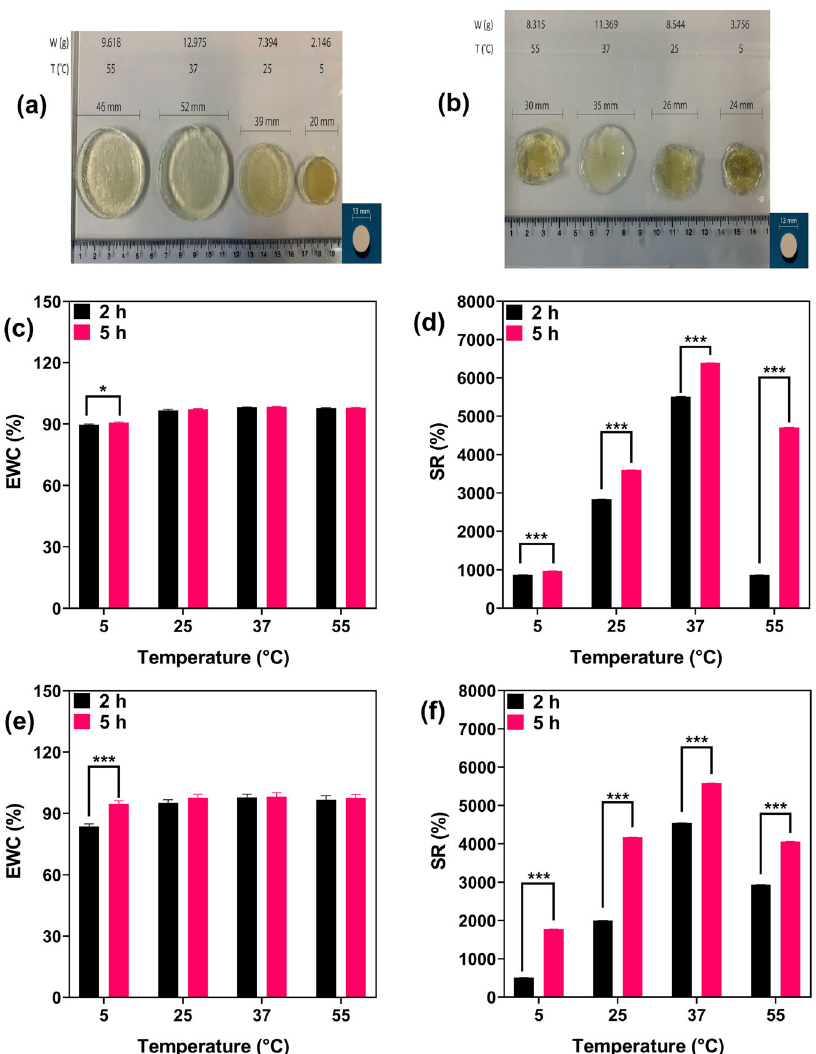
Fig. 9 The effect of temperature on swelling behavior of hydrogels. a CS-g-gly dry tablet, ( b ) CMCS-g-gly dry tablet, ( c ) CS-g-gly EWC (%), ( d ) CS-g-gly SR (%) ( e ) CMCS-g-gly EWC (%), ( f ) CMCS-g-gly SR (%), in different temperature after 2 and 5 h. Each experiment was performed and replicated three times, and the results were displayed using error bars to depict the